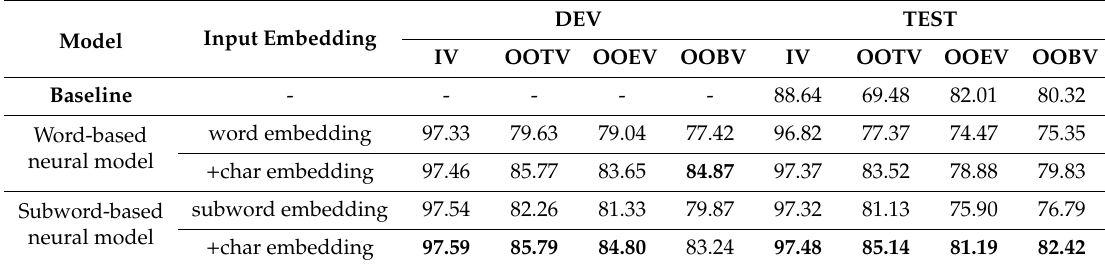
Table 6. Comparison of performance on di ff erent subsets of entities